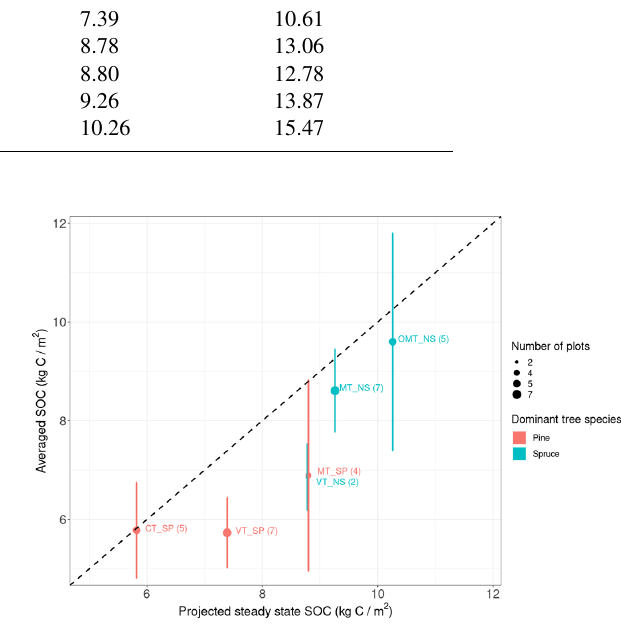
Figure 4. The projected steady-state SOC compared to the averaged measured SOC values in plots from multiple measurement sites.